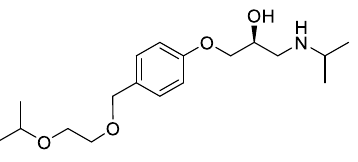
Figure 1. Structure of ( S )-bisoprolol.